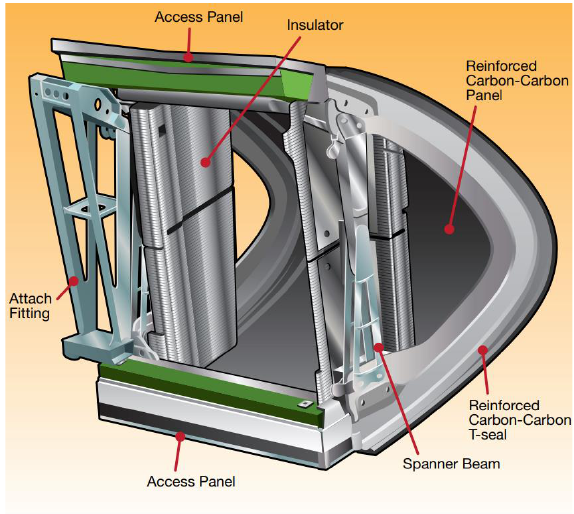
Figure 1. Thermal protection system of a space shuttle orbiter: tile placement ( top ) and wing panel assembly ( bottom ) [8]. Credit: NASA.